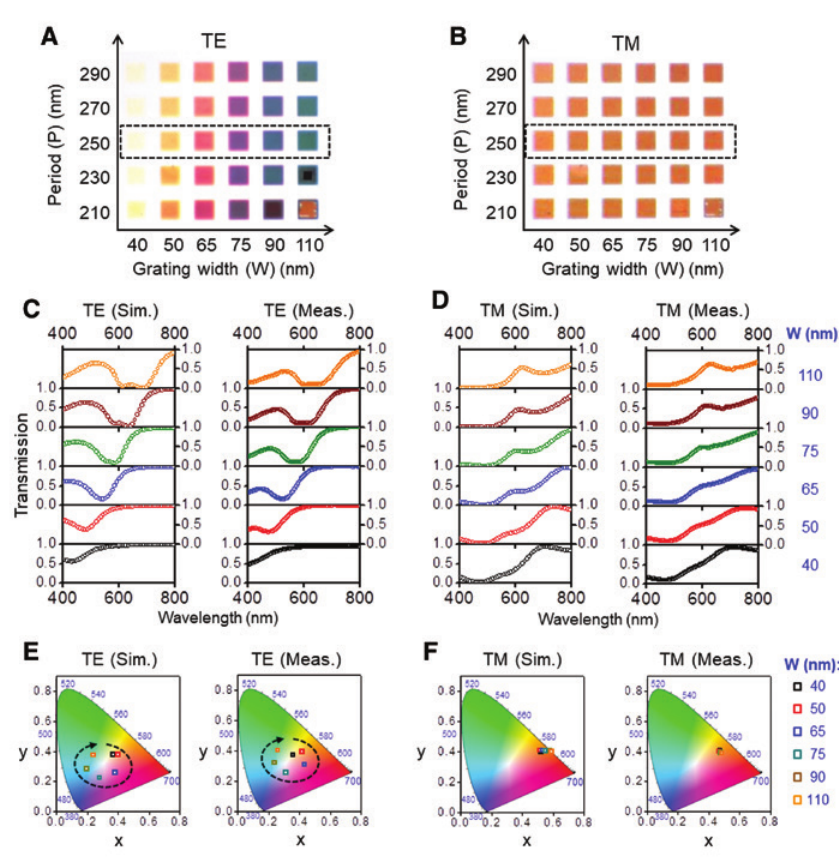
Figure 2: Simulated and measured optical performances of the proposed color pixels. The bright-field microscopy images of the manufactured color palette with the stepwise tuning of W and P under the (A) TE and (B) TM polarized illuminations. Each pixel belonging to the color palette has a footprint of 30 μ m × 30 μ m. Simulated and measured transmission spectra for the pixels, marked by a dotted box in 2(A) and 2(B), under the (C) TE and (D) TM polarized illuminations. The corresponding chromaticity coordinates of the color pixels in the CIE 1931 chromaticity diagram for the (E) TE and (F) TM